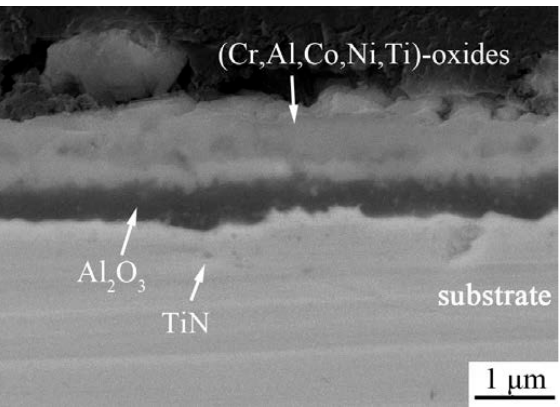
Figure 6. Cross-section morphologies of the oxide scale formed on the E7 alloy after oxidation at 1000 °C for 4 h.